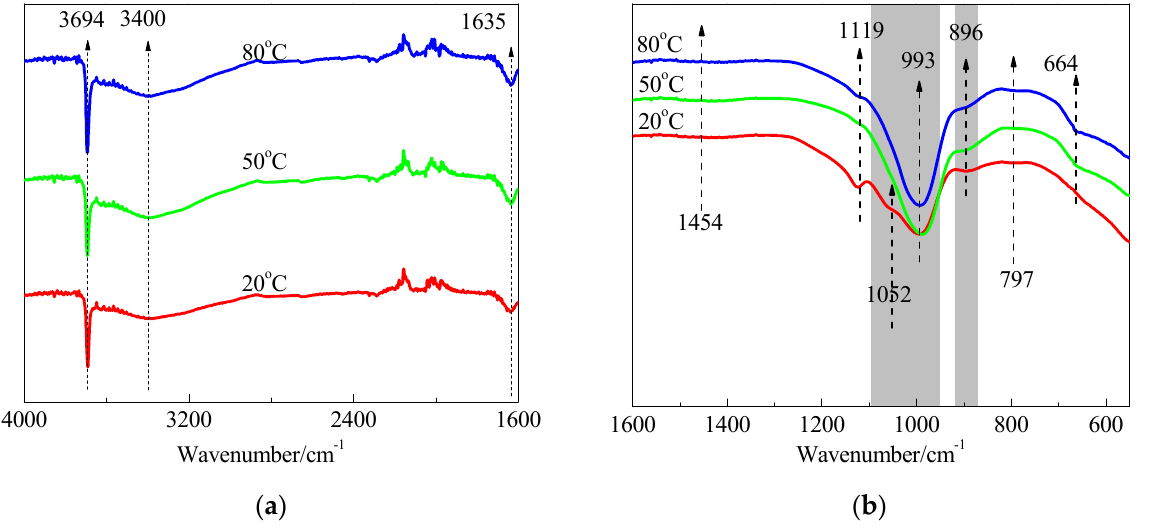
Figure 14. FTIR spectra of MgO-SF pastes prepared using MgO calcined at 1450 °C for 30 min after 28 d: ( a ) 4000 cm − 1 –1600cm − 1 and ( b ) 1600 cm − 1 –550cm − 1 .